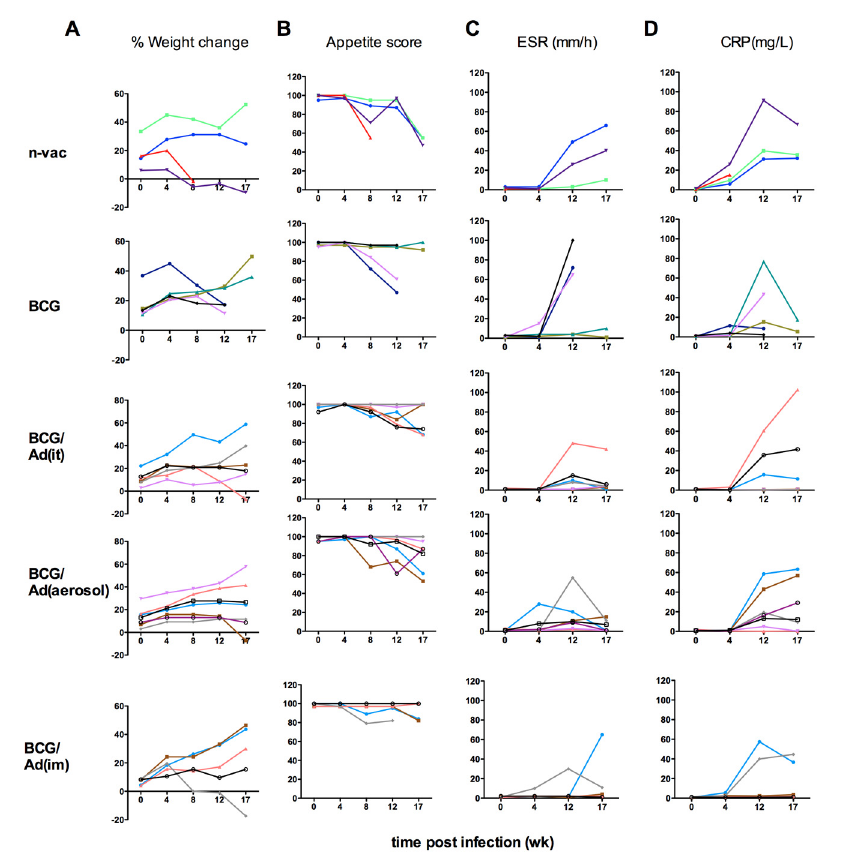
Fig 6. Longitudinal kinetics of clinical outcomes during the course of infection. Clinical outcomes were monitored at scheduled times as indicated in the experiment plan and as described in Methods. Line graphs depict ( A ) percent of weight change relative to weight at the start of the experiment, ( B ) appetite, ( C ) change in erythrocyte sedimentation rate (ESR), and ( D ) C-reactive protein (CRP). Lines represent individual animals in each group and color assigned to individual animal in each group is maintained to display each clinical sign evaluated for comparability. Wilcoxon ranked test is used to compare clinical signs post infection relative to values before